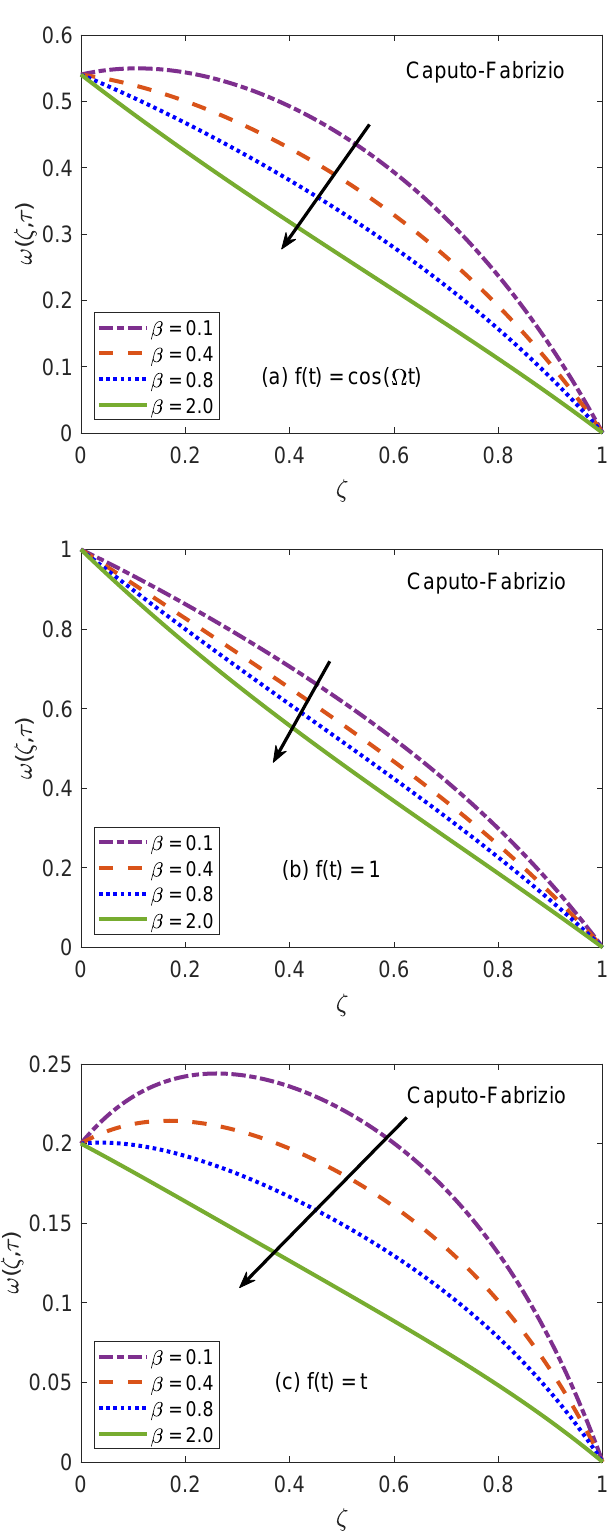
Figure 11. Velocity patterns for variation of β